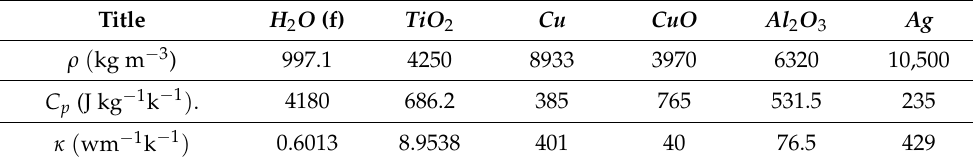
Table 2: Thermo-physical properties of base fluids and nanoparticles [55]. Table 2. Thermo-physical properties of base fluids and nanoparticles